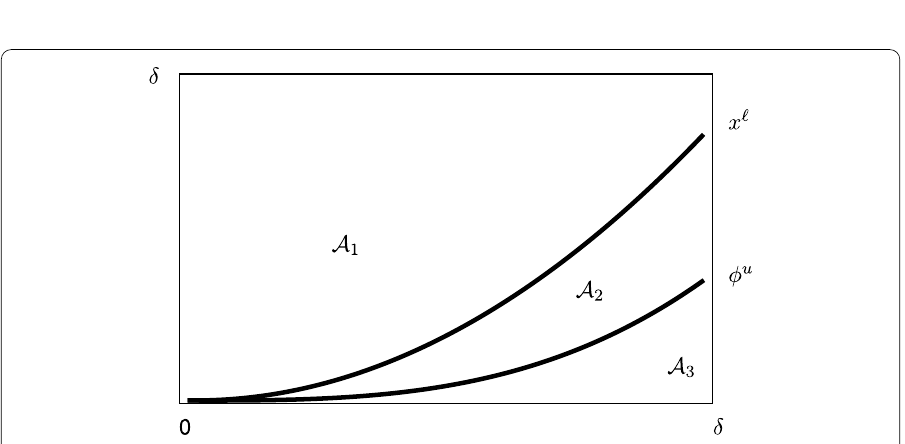
Figure 6 The region [0, δ ] × [0, δ ] is partitioned into three regions A 1 , A 2 , and A